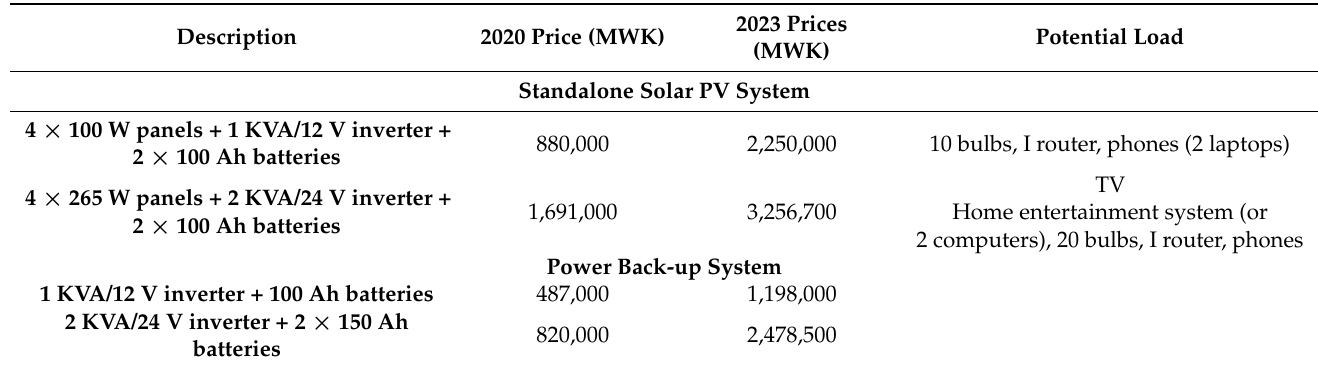
Table 6. Price comparison for solar products in 2020 vs. 2023.